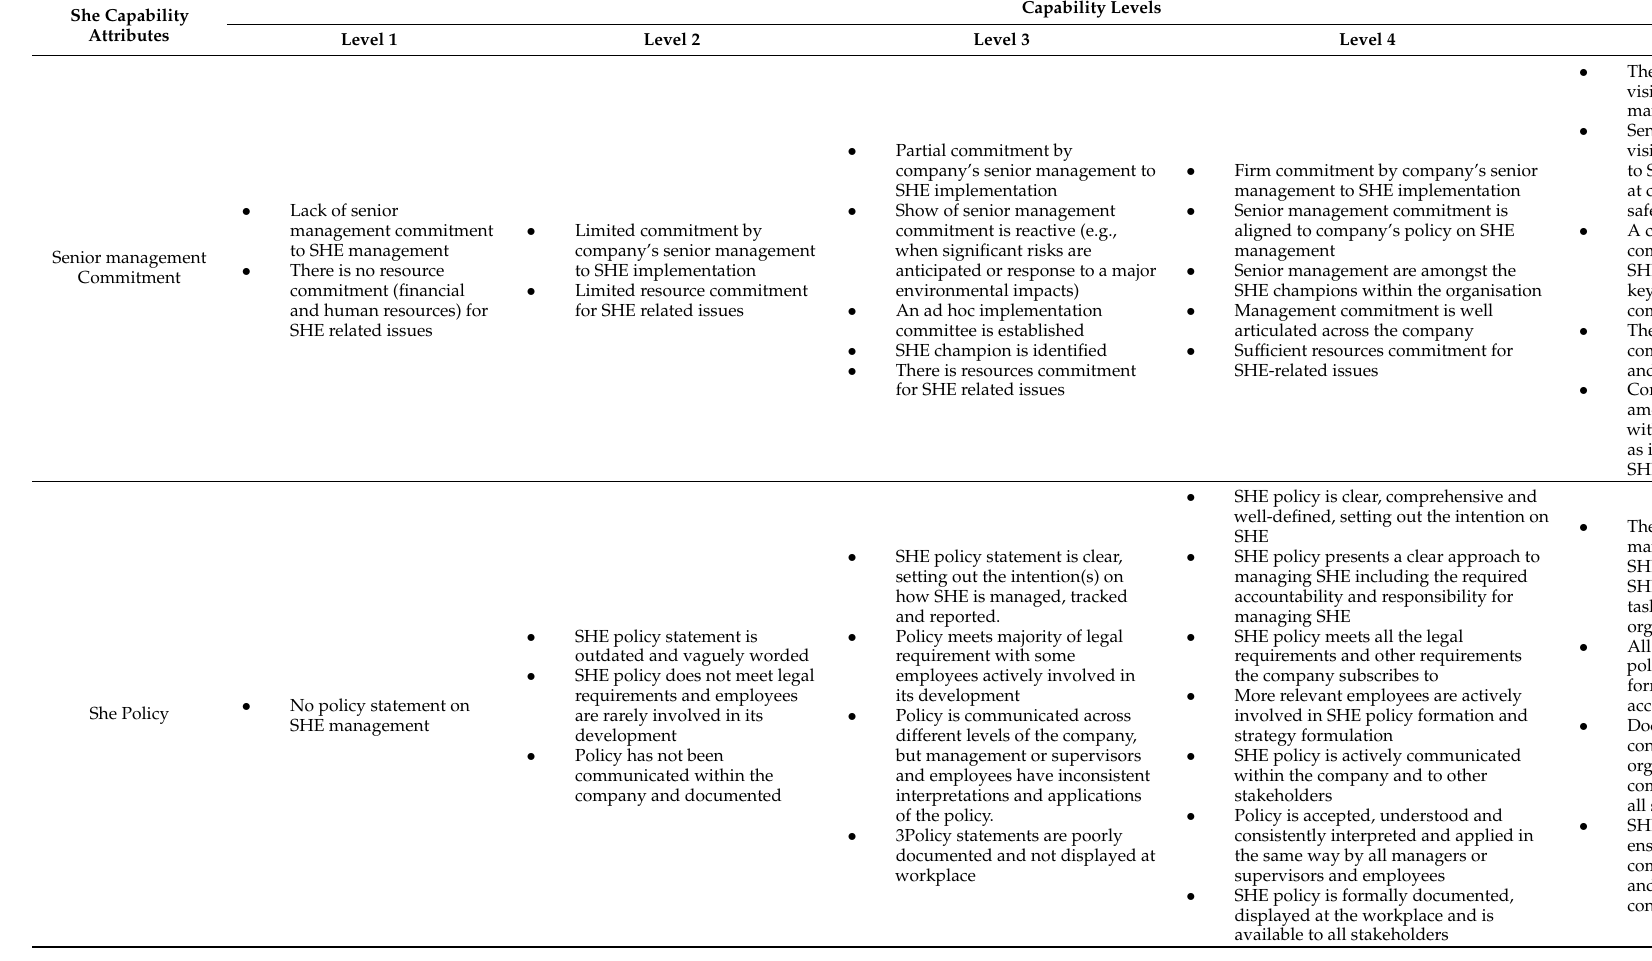
Table A1. Integrated safety, health and environmental management capability maturity model (iSHEM-CMM). Integrated Safety, Health and Environmental Management Capability Maturity Model